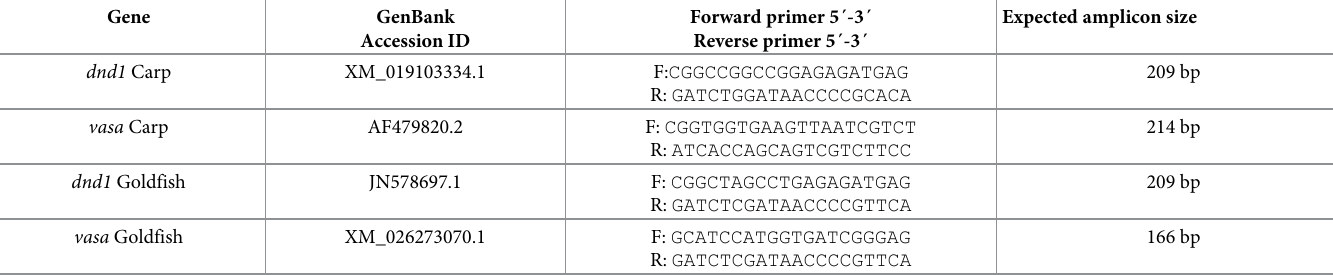
Table 1. Primers used for confirmation of donor-derived origin of transplanted cells in recipients.